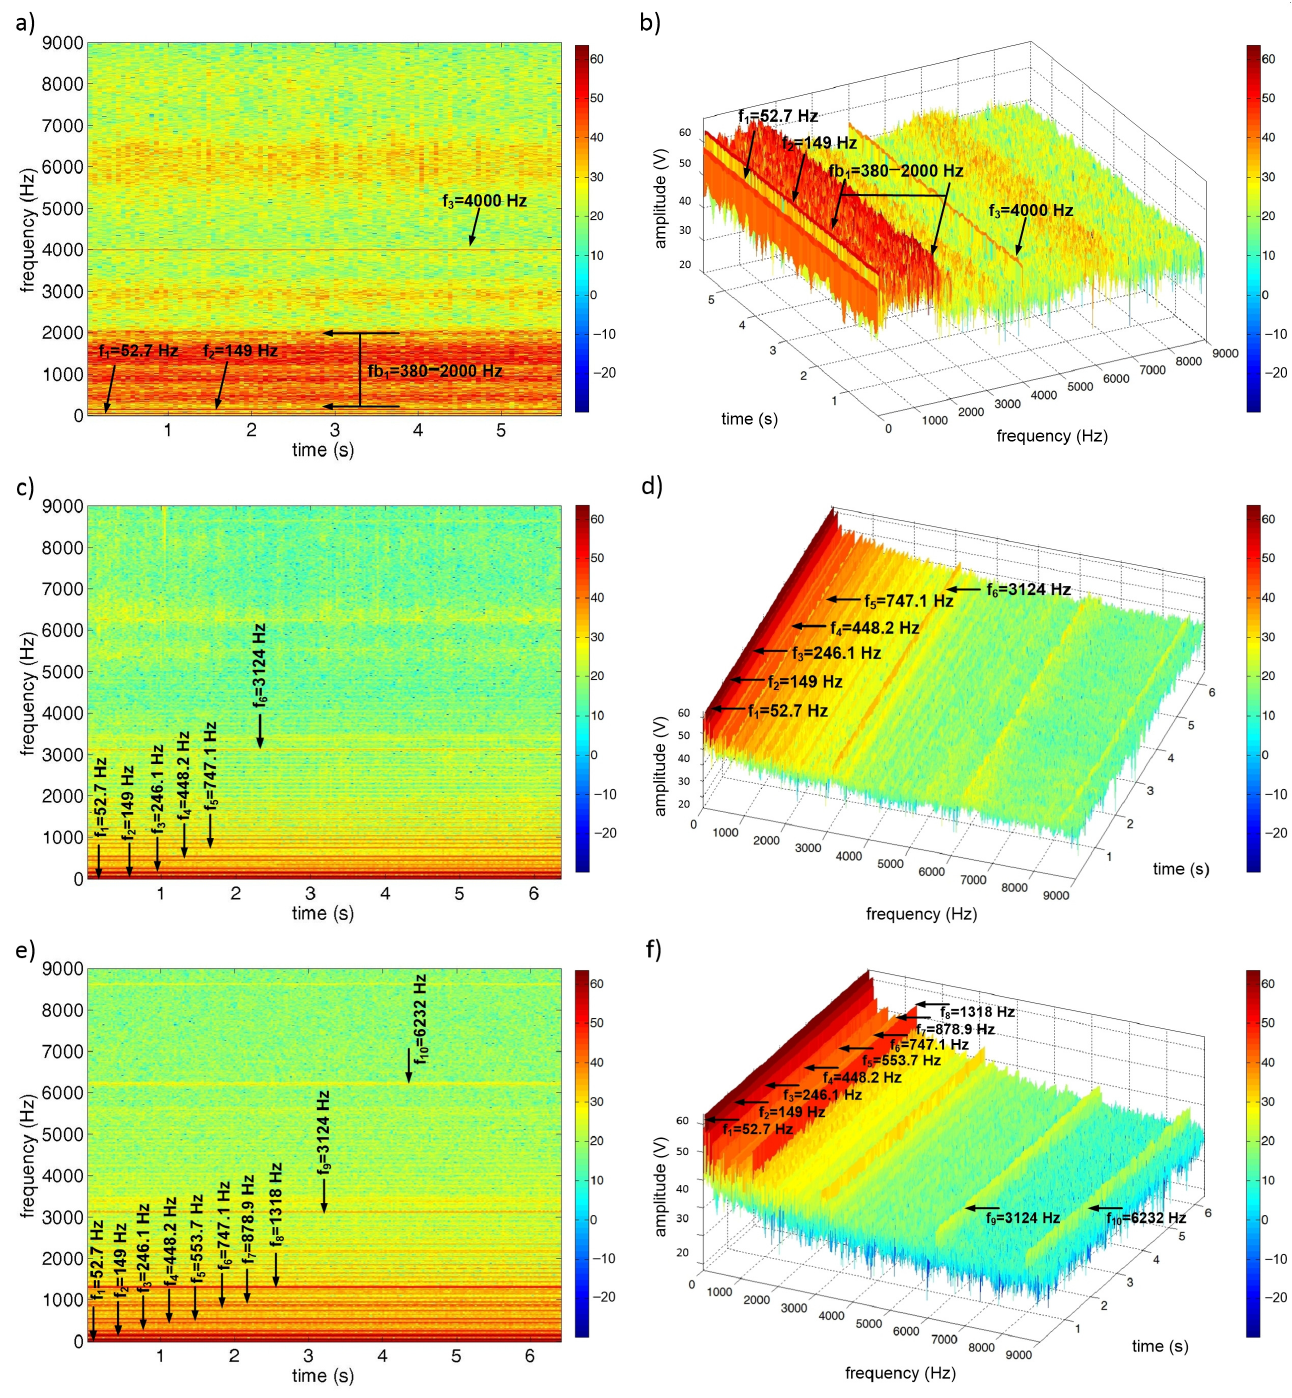
Figure 13. Spectrograms of vibration signals of acceleration (( a ) 2D view of motor signal spectra, ( b ) 3D view of motor signal spectra, ( c ) 2D view of water pump signal spectra, ( d ) 3D view of water pump signal spectra, ( e ) 2D view of hydro-generator signal spectra, ( f ) 3D view of hydro-generator signal